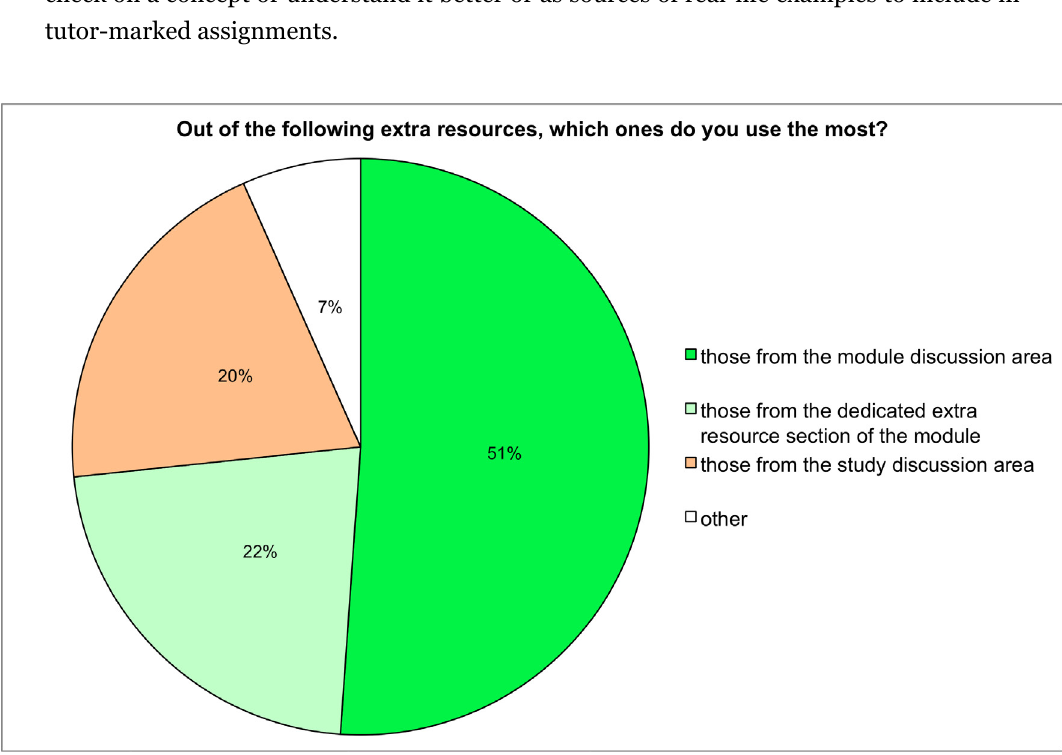
Figure 6 . Student use of extra resources depending on their type and